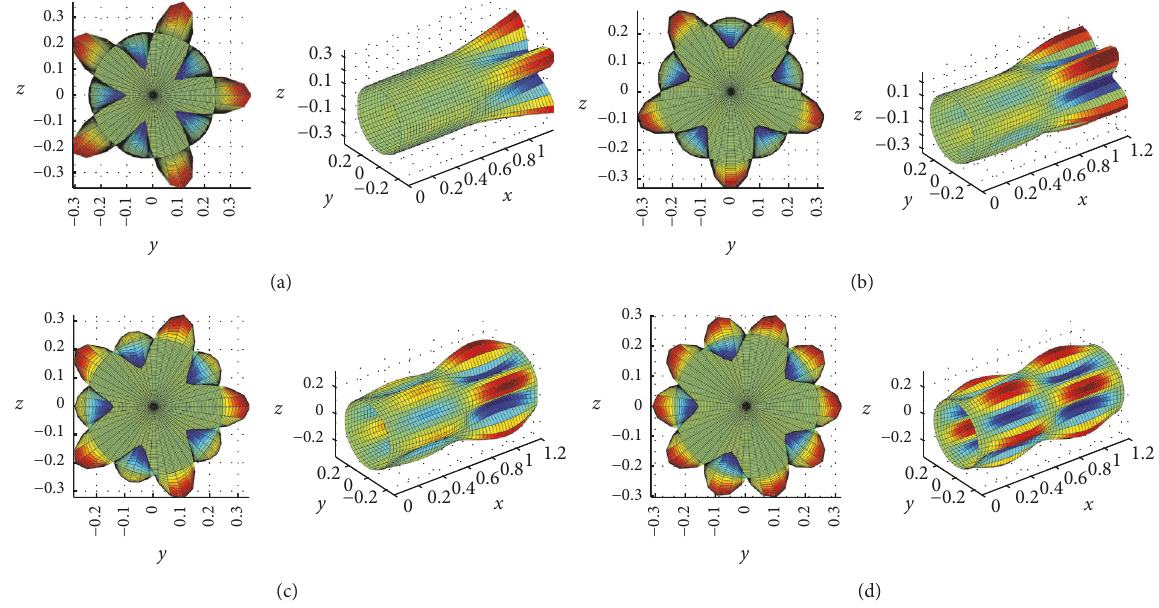
Figure 10: The 𝑆(1, 5) modes of coupled structures with C-E boundary condition: (a) 𝑘𝑥 = 𝑘𝑟 = 𝐾𝑟 = 0 and 𝑘𝜃 = 1𝐸4 , 213.21 Hz; (b) 𝑘𝑥 = 𝑘𝑟 = 𝐾𝑟 = 0 and 𝑘𝜃 = 1𝐸8 , 263.48 Hz; (c) 𝑘𝑥 = 𝑘𝑟 = 𝐾𝑟 = 0 and 𝑘𝜃 = 1𝐸12 , 313.74 Hz; and (d) C-C, 358.82 Hz.